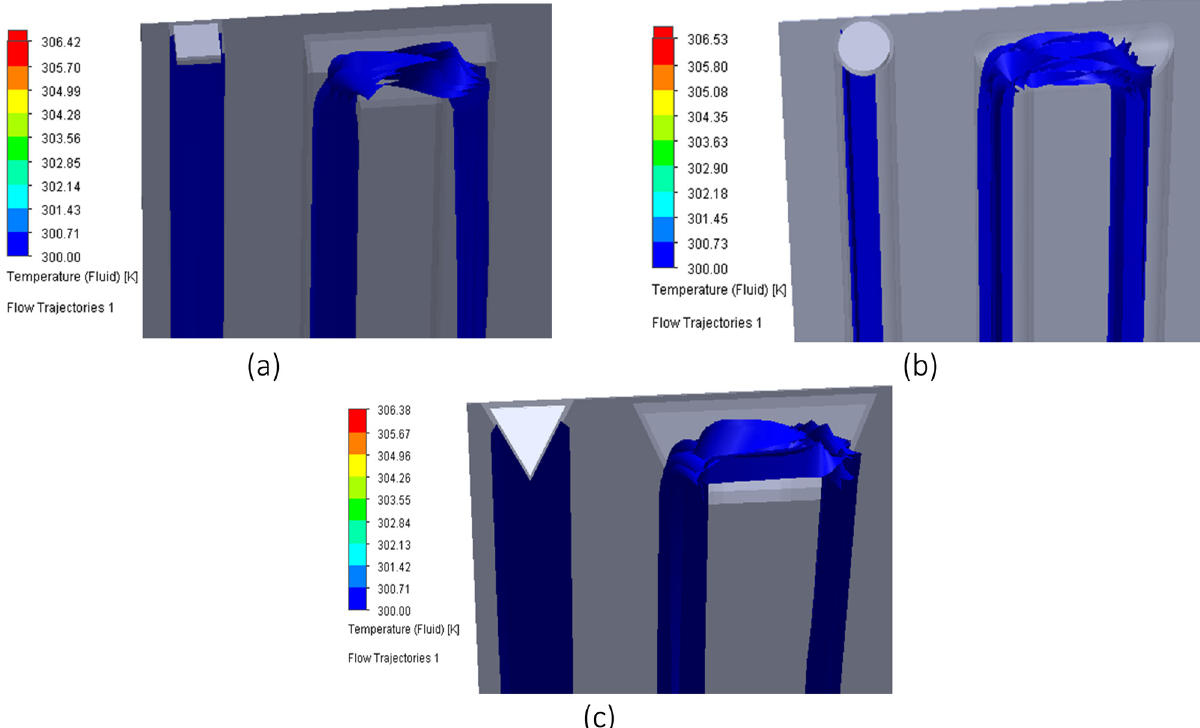
Figure 7: Water fl ow at the corner of the collector edge: ( a ) square box, ( b ) pipe box, and ( c ) triangular